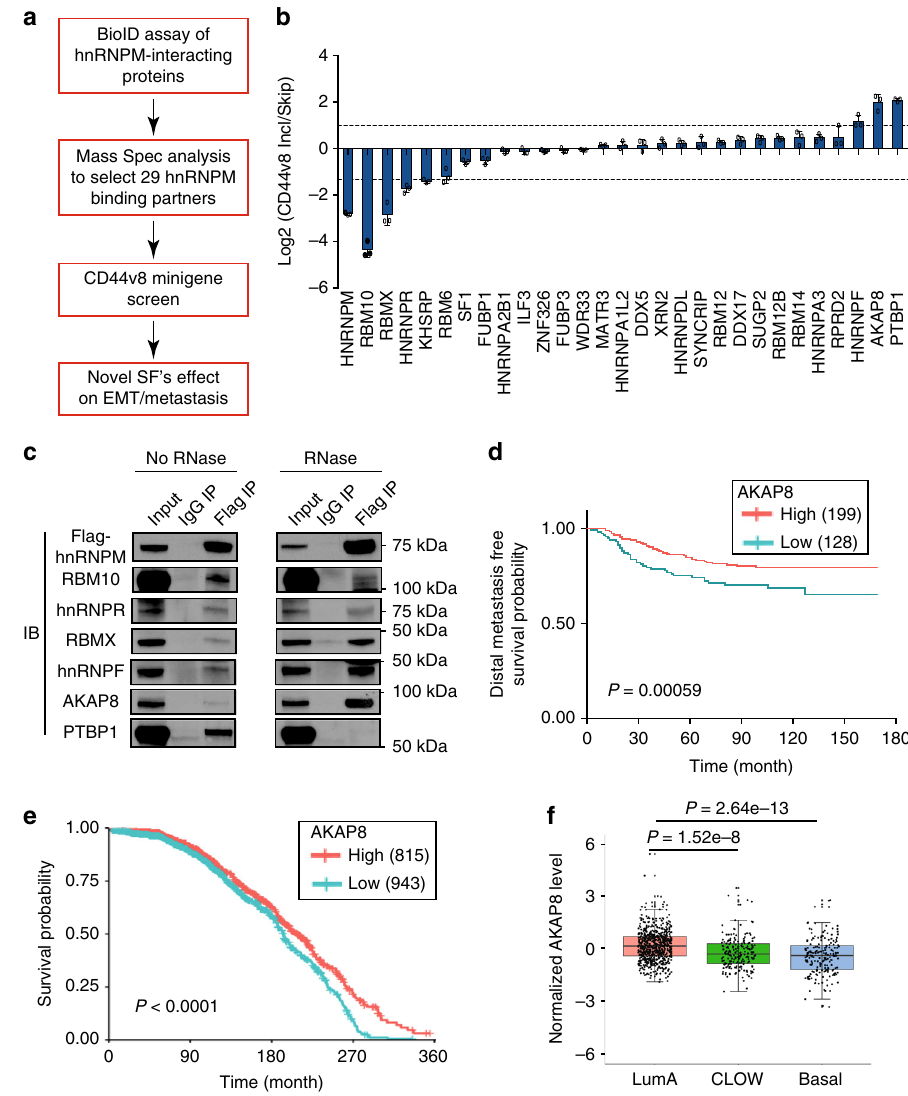
Fig. 1 Functional screening to identify AKAP8 as an hnRNPM-interacting protein. a A fl ow chart showing the experimental approaches to identify hnRNPM-interacting proteins. b qRT-PCR analysis of the CD44v8 splicing reporter minigene screening for the candidate splicing factors. Data were plotted as the Log2 transformed v8 exon inclusion versus skipping with mean ± s.d, n = 3. Incl: Inclusion. c Western blot analysis showing the interactions between hnRNPM and its candidate interacting proteins. A Flag-tagged hnRNPM cDNA was transfected into the 293 cells and immunoprecipitated with a Flag antibody with or without RNase treatment. Antibodies recognizing speci fi c candidates were used for western blot analysis. d Kaplan – Meier plot analysis of breast cancer patient distal metastasis-free survival (GSE20685, n = 237) showing that higher levels of AKAP8 expression predict lower metastatic potential. P value was calculated by log-rank test. e Kaplan – Meier plot analysis of the METABRIC breast cancer data set ( n = 1758) showing that higher expression of AKAP8 shows better patient survival probability. f Box and whiskers plots with jitters representing distribution of AKAP8 mRNA expression levels in luminal A (LumA), claudin low (CLOW), and basal (Basal) breast cancers patients from the breast cancer METABRIC data set. The line within each box represents the median. Upper and lower edges of each box represent 75th and 25th percentile, respectively. The whiskers represent the maximum and minimum values within 1.5× the interquartile range. P values were calculated by two sample z test in e , f . Source data are provided as a Source Data fi